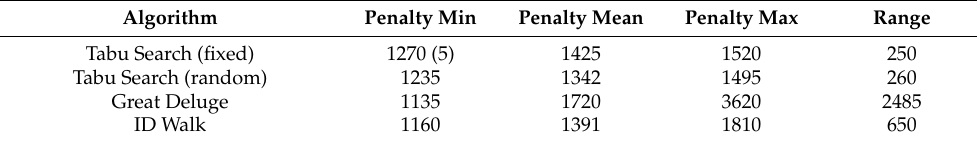
Table 2. Comparative